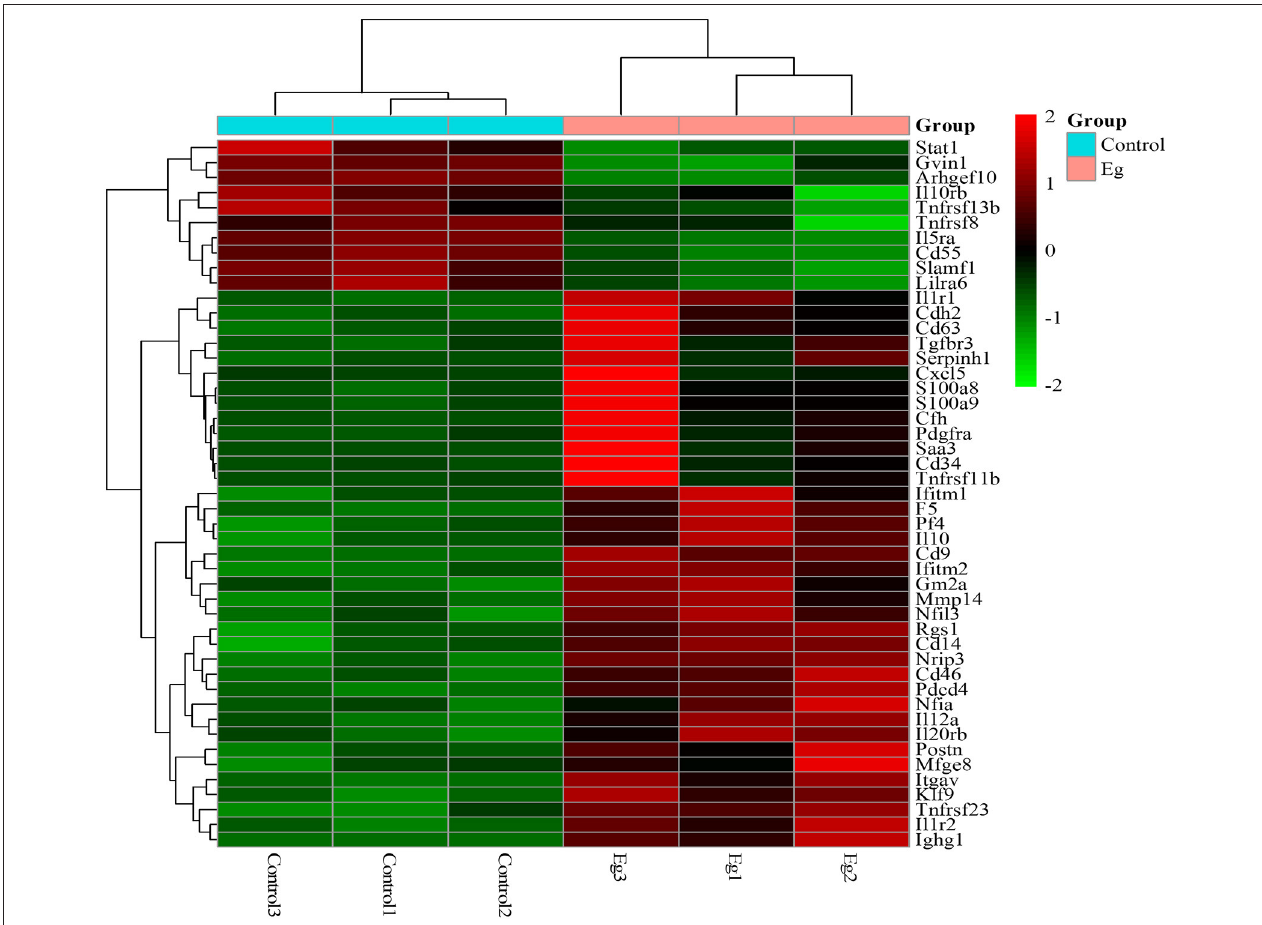
FIGURE 5 | The heatmap of DEGs related to inflammatory signaling molecules, cytokine, and chemokines in the splenic B cells infected with the larval E. granulosus . Red color means the upregulated mRNAs and green color means the down-regulated